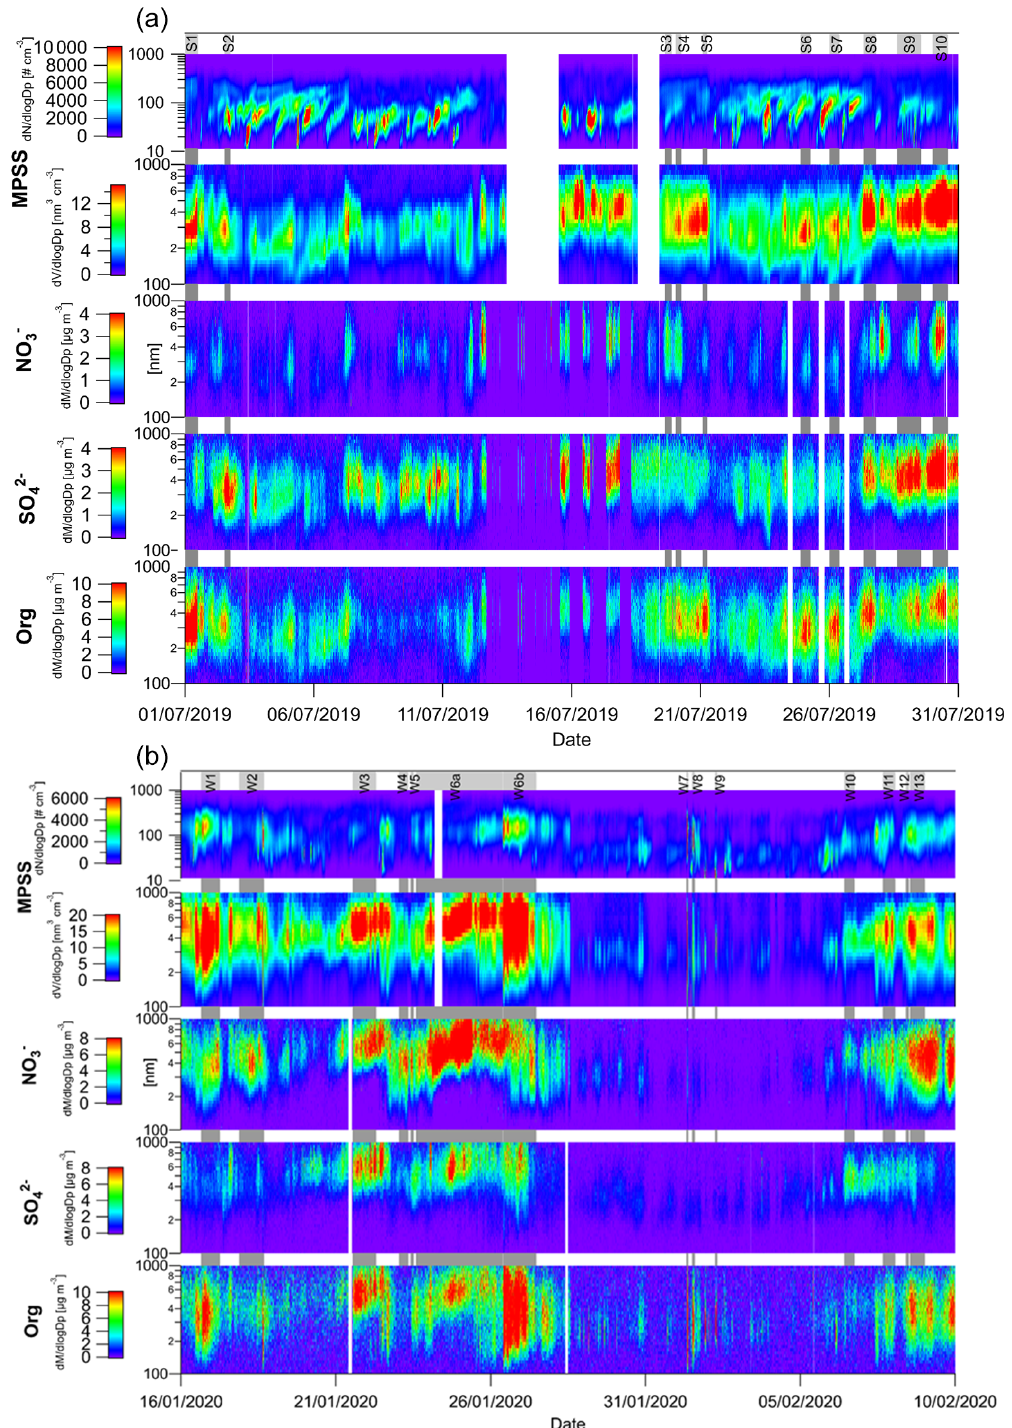
Figure 2. Time series of particle number and volume concentrations obtained by MPSS ( D va recalculated from mobility diameter) and mass size distributions of nitrate, sulfate, and organics obtained by AMS in summer (a) and in winter (b) with marked episodes of higher mass